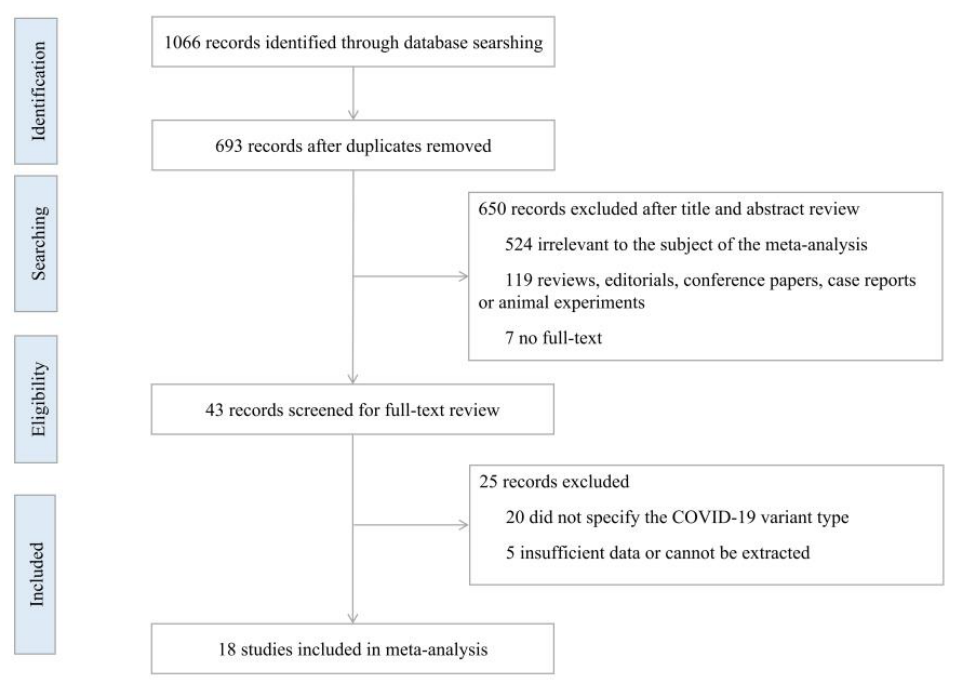
Figure 1. Flowchart for study Figure 1 . Flowchart for study selection.